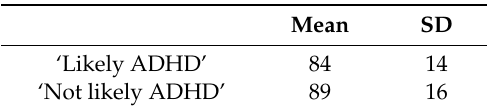
Table 4. Means and standard deviations of GABS scores.